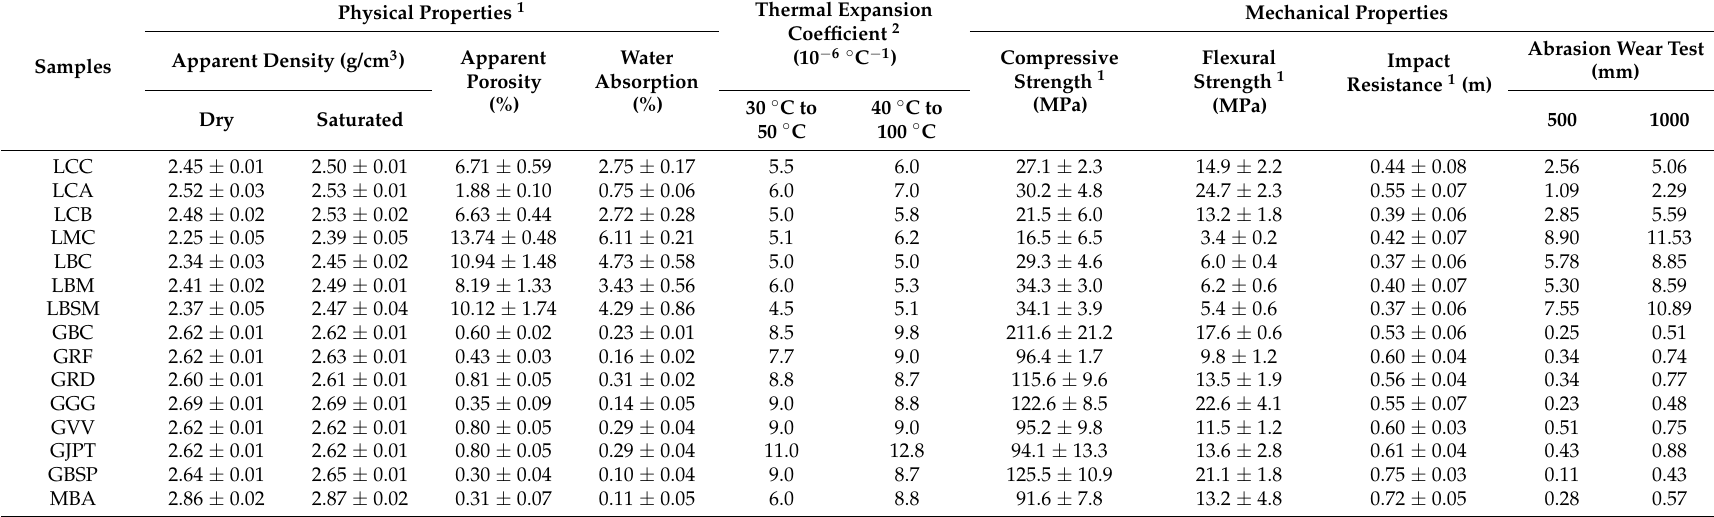
Table 6. Physical properties, thermal expansion coefficients, and mechanical properties of limestones, granites, and marble.